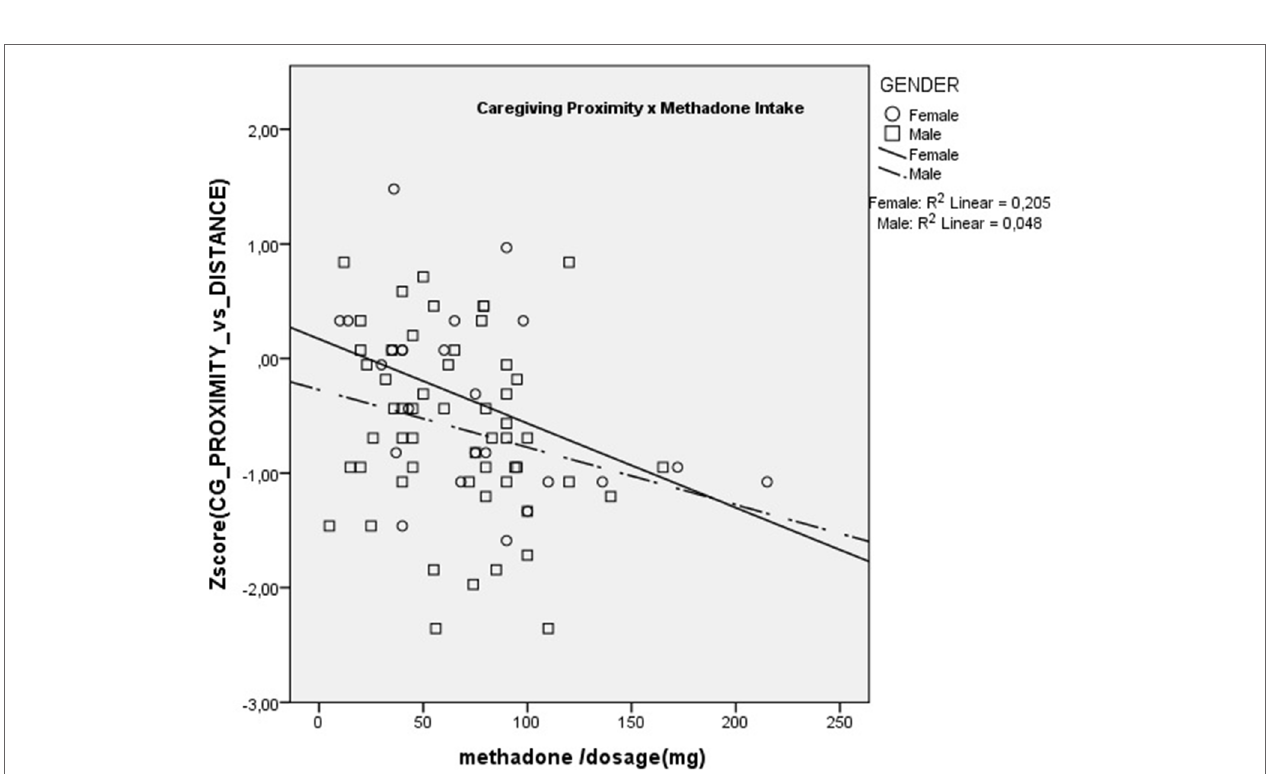
FIGURE 2 | Scatterplot of Correlation between methadone dose and Caregiving